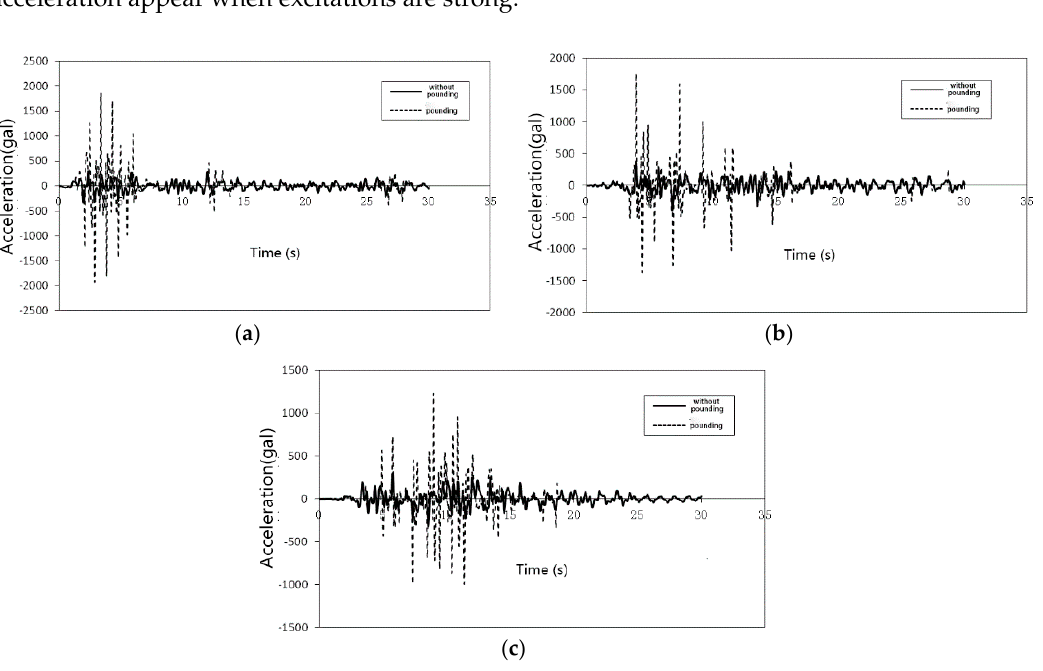
( b ) ( c ) Figure 17. Structural acceleration under different earthquakes (model B). ( a ) El Centro earthquake; ( b ) Taft earthquake; ( c ) Artificial excitation. Table 4. Maximum acceleration values for model A. Earthquake